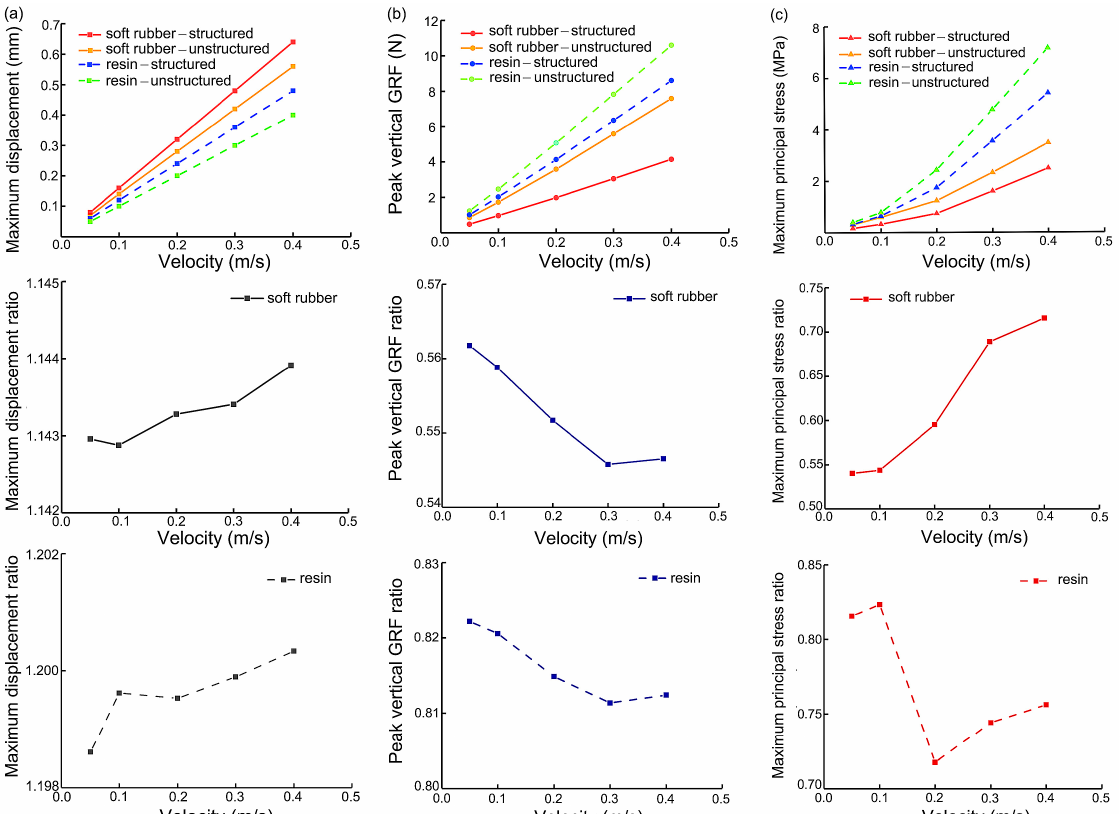
Figure 5. Maximum vertical displacement ( a ), peak vertical GRF ( b ), and maximum principal stress ( c ) of the four bionic heel pads under impact of different speeds in FE simulations. Maximum values ( top ) with different structures and materials, along with the ratio of the maximum value of the structured to the unstructured sample using same soft rubber ( middle ) or resin ( bottom ) material were depicted.